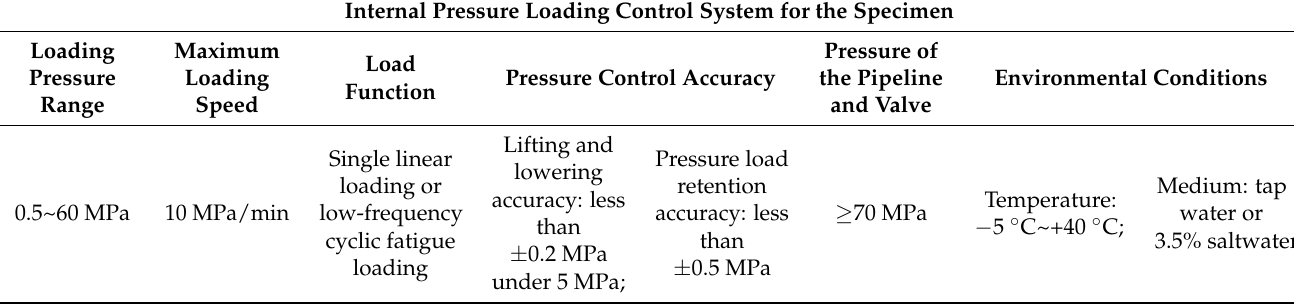
Table 1. Internal pressure loading system